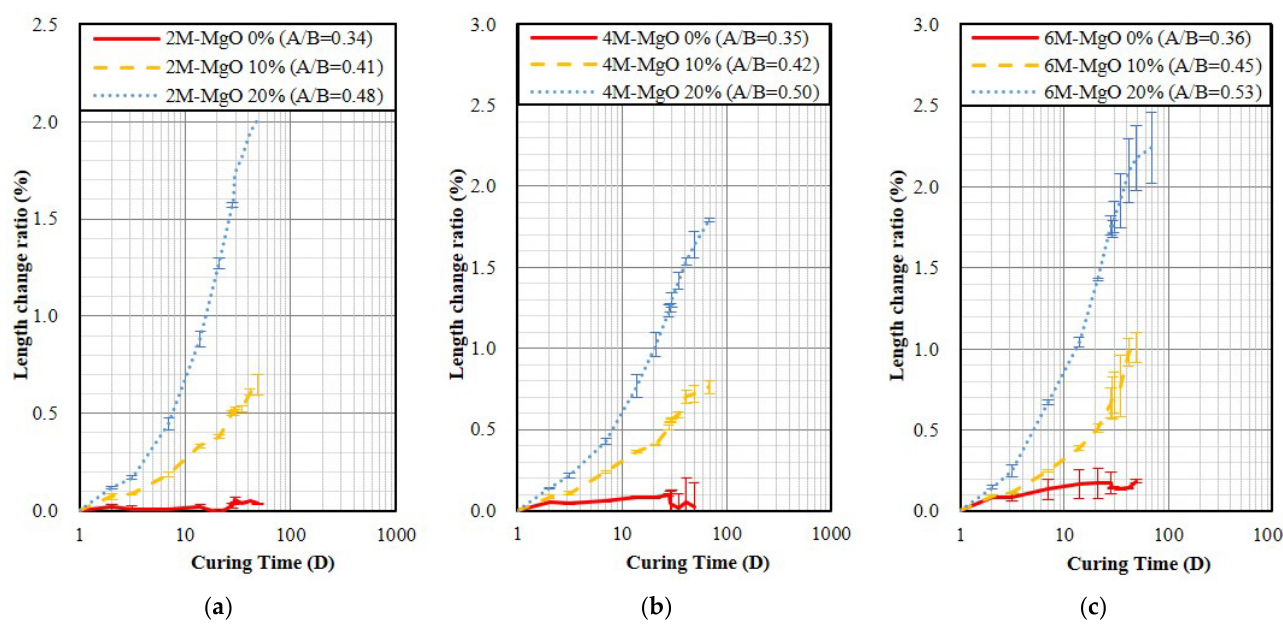
Figure 8. The length change ratio of the specimen demold at age of 24 h and steam curing. ( a ) 2 M; ( b ) 4 M; ( c ) 6 M. ( b ) 4 M; ( c ) 6